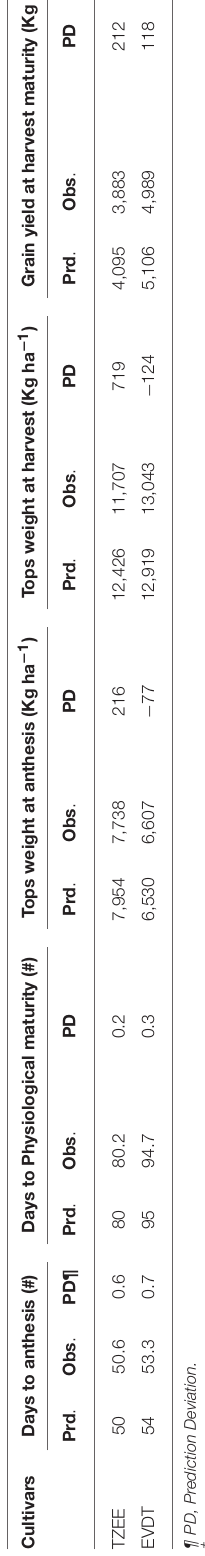
TABLE 4 | Mean observed values for harvest index, days to anthesis, and grain yield per hectare of maize with corresponding RMSE, r-square, and EF-values combined for 2014 and 2015 under irrigated and rainfed conditions.